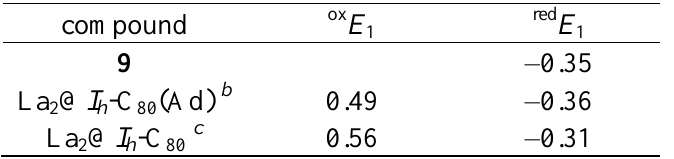
@ I -C and its derivatives a 2 h 80